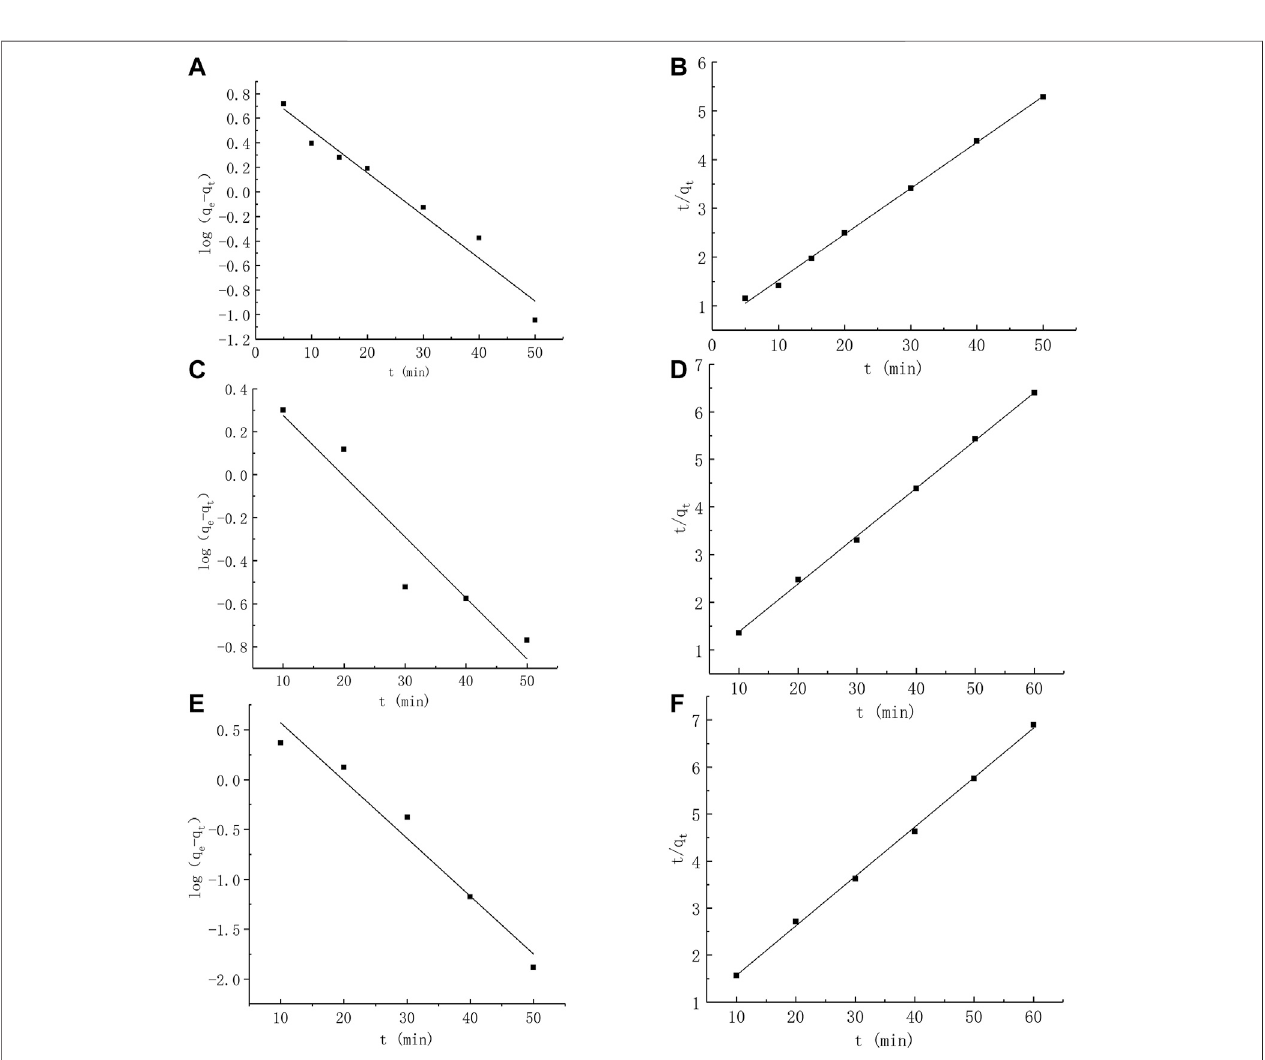
FIGURE 6 | Kinetic model of the adsorption on Pb 2+ (A) : Pseudo fi rst-order kinetic model of BC; (B) pseudo second-order kinetic model of BC; (C) : Pseudo fi rst- order kinetic model of CTS-BC; (D) pseudo second-order kinetic model of CTS-BC; (E) : Pseudo fi rst-order kinetic model of BC-CTS; (F) pseudo second-order kinetic model of